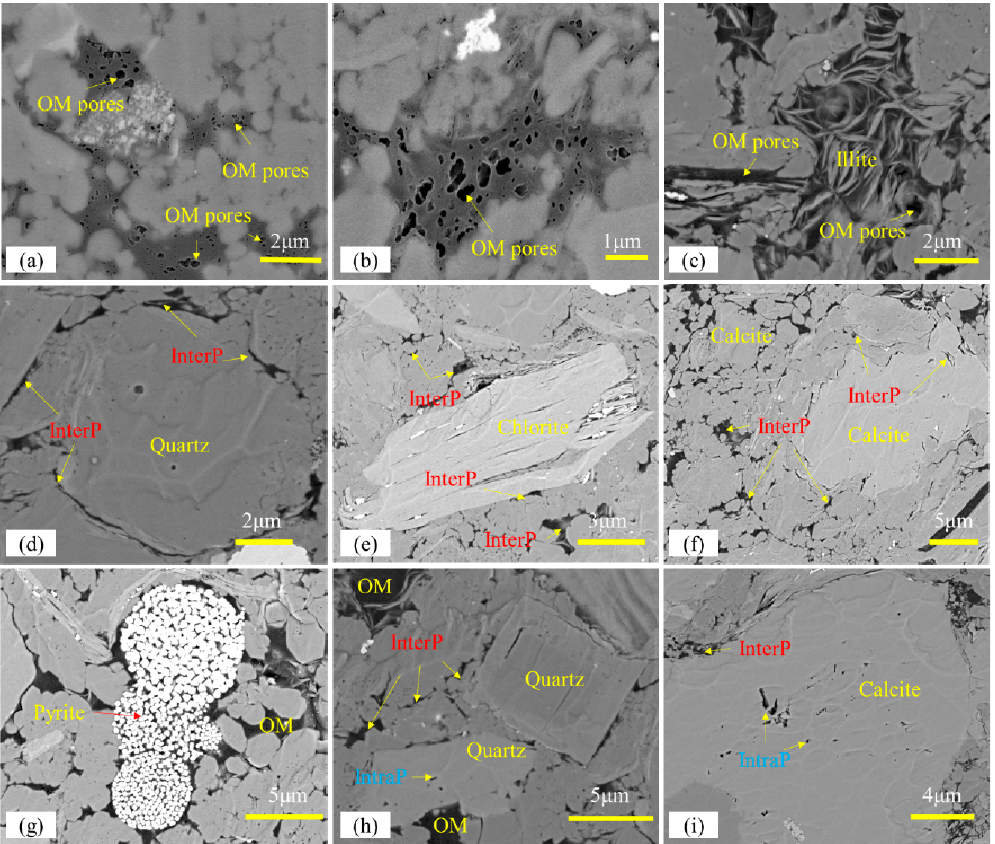
Figure 1. Example of pores in W-L shale sample J4-5. ( a )–( b ) Large organic matter (OM) particles with elliptical bubbles and irregular polygon shapes; ( c ) complex OM pores within the illite interlayers; ( d )–( f ) interP pores between quartz, clay minerals, and calcite grain rims; ( g )–( h ) quartz and pyrite framboids with inter crystal pores filled with OM and with OM pores; ( i ) intraP pores observed within calcite grain.